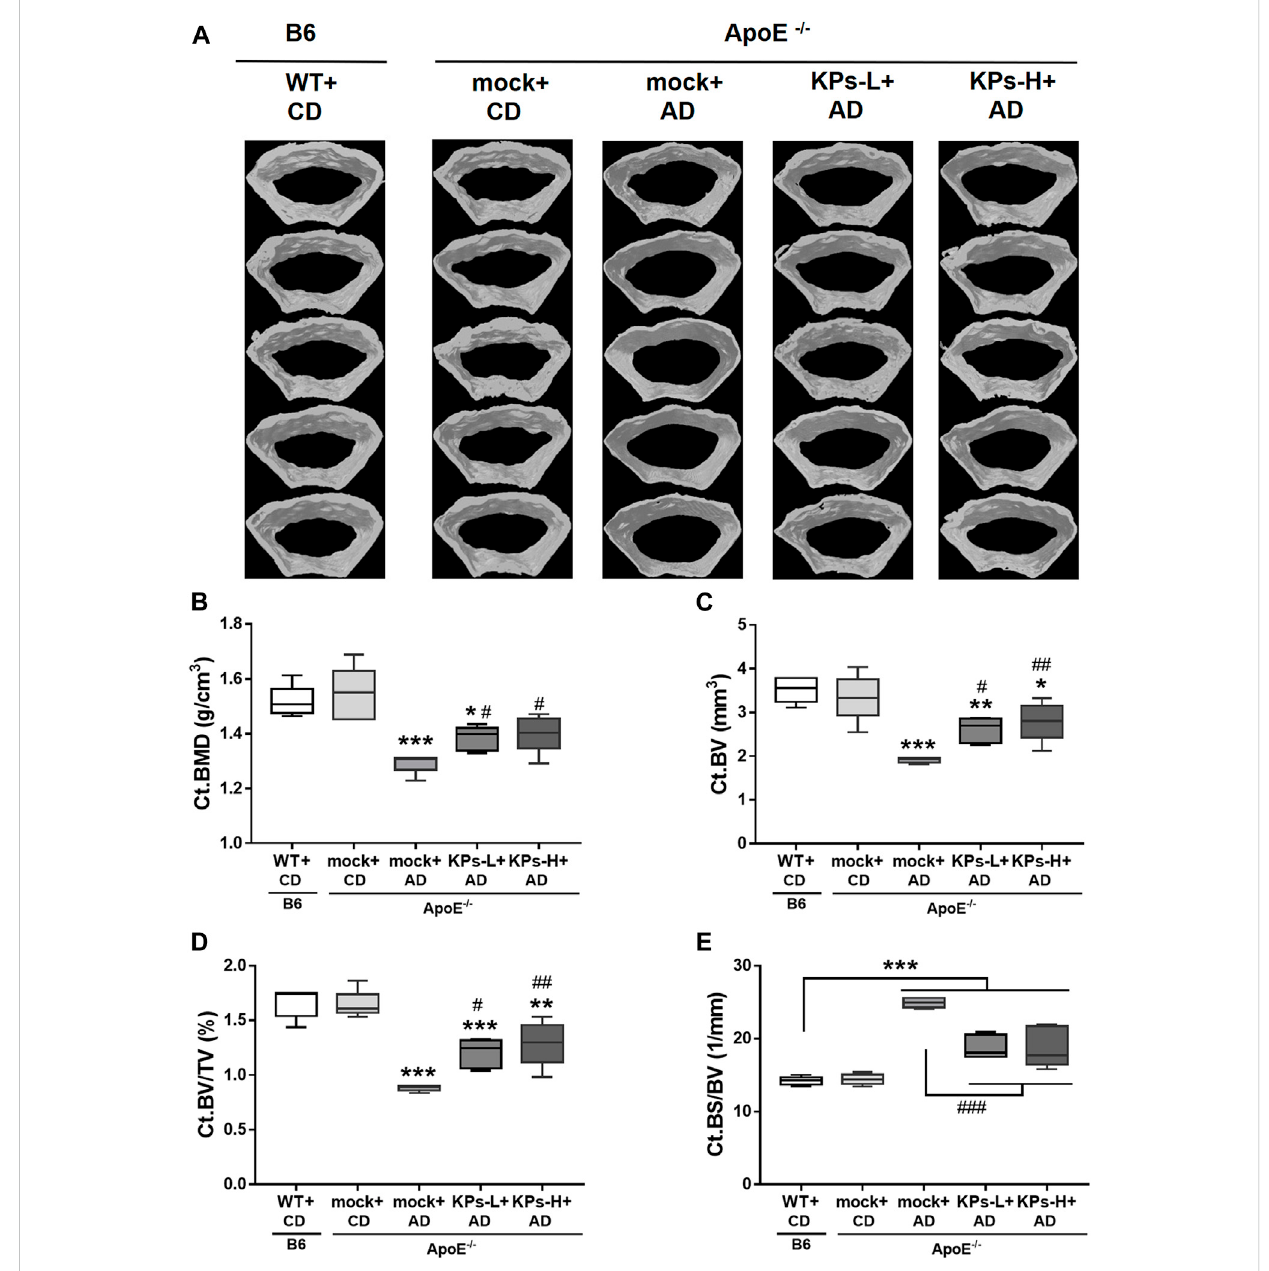
FIGURE 5 KPs increase cortical bone (Ct) volume in AD-fed ApoE − / − mice. The effects of KPs on femoral cortical bones were evaluated using micro-CT. (A) Reconstituted images of Ct structures from each mouse. The structural parameters of (B) Ct. BMD, (C) Ct. BV, (D) Ct. BV/TV, and (E) Ct. BV/SV are shown as indicated. Statistical signs ( n = 5): * p < 0.05, **( p < 0.01, *** p < 0.001 vs. WT + CD/B6, and # p < 0.05, ## p < 0.01, ### p < 0.001 vs. mock + AD/ ApoE − / −